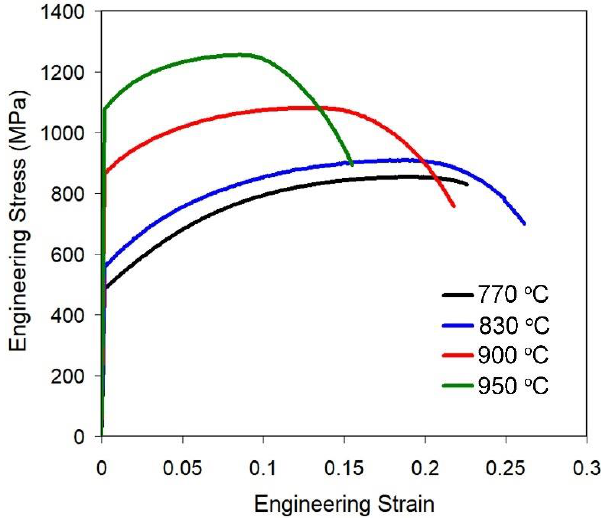
Figure 3. “Engineering strain–Engineering stress” curves depending on the temperature of the intercritical annealing.